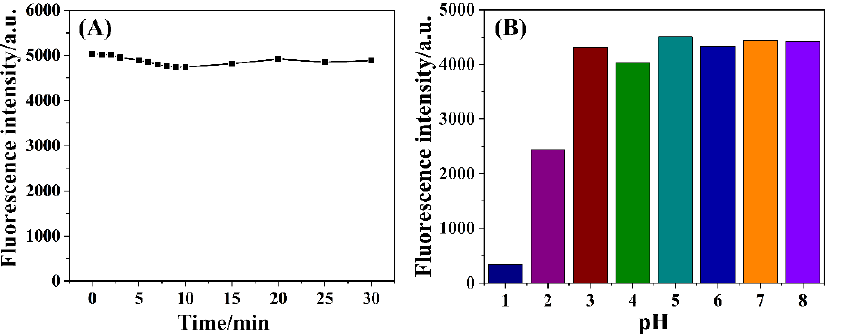
Figure 6. ( A ) Effect of the detection time on the fluorescence intensity; ( B ) influence of the pH on the fluorescence intensity.